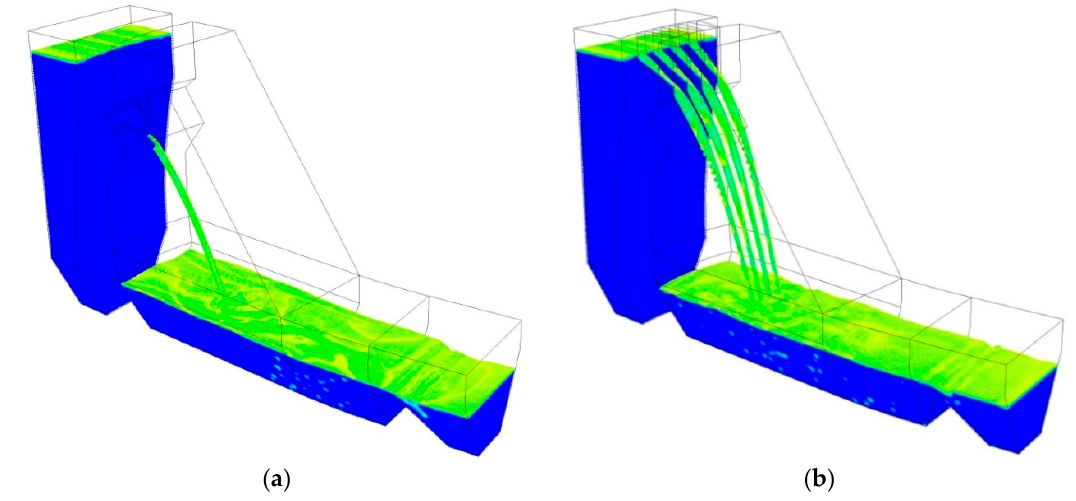
Figure 8. Flow regime of the numerical calculation region: ( a ) Condition 2; ( b ) Condition 6.